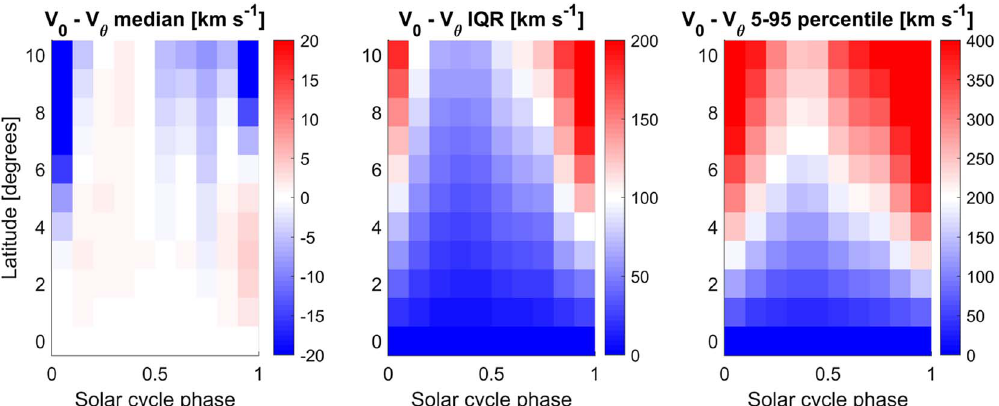
Fig. 6. V 0 (cid:3) V h , solar wind speed difference between the equator and other latitudes, as a function of solar cycle phase and latitude. Left: the median of V 0 (cid:3) V h . Centre: the inter-quartile range of V 0 (cid:3) V h . Right: the 5 – 95-percentile range of V 0 (cid:3) V